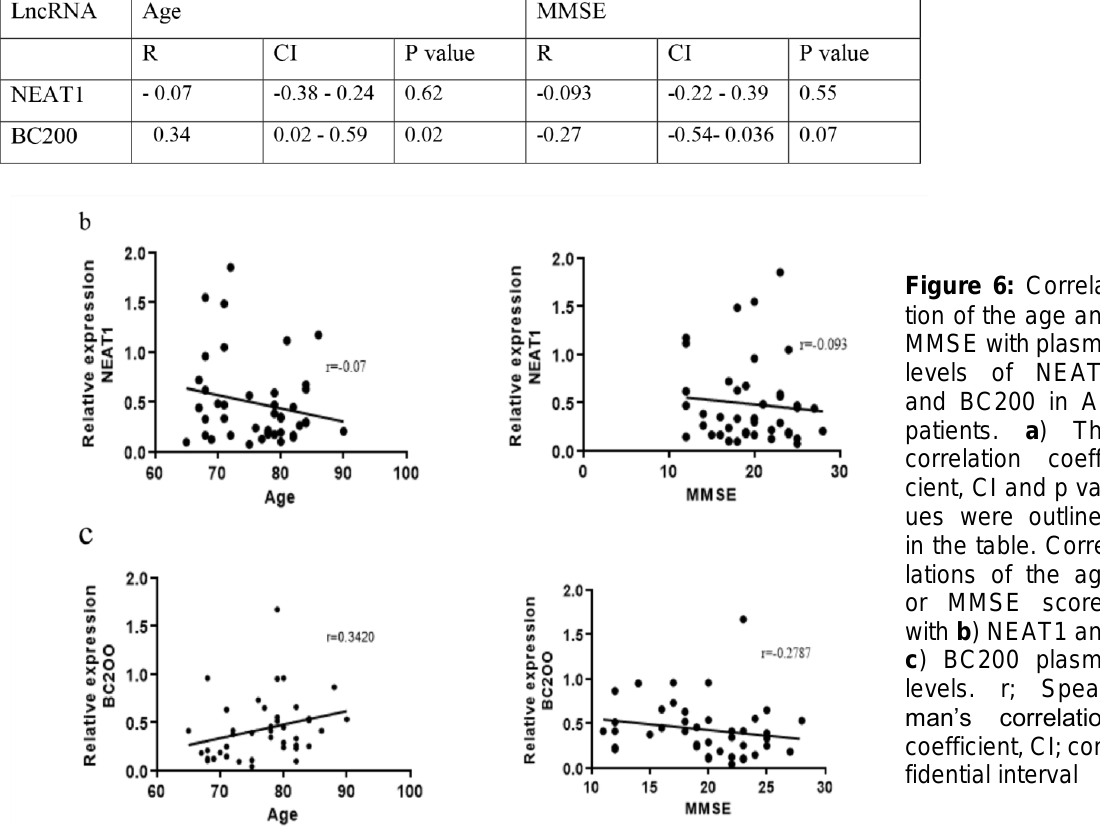
tion of the age and MMSE with plasma levels of NEAT1 and BC200 in AD patients.